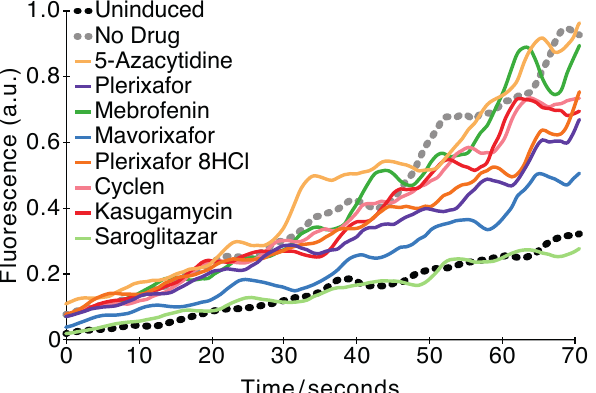
Figure 4. Fluorescence-based conductivity assay. The fluorescence of bacteria that harbor a pH- sensitive GFP [32] and express the SARS-CoV-2 E protein was examined as a function of different chemicals at a concentration of 100µM. The experiment was performed as previously described [33], whereby at time 0, a concentrated solution of citric acid was injected into the media. The results may be compared to those obtained without any drug (black) or when the channel expression was not induced